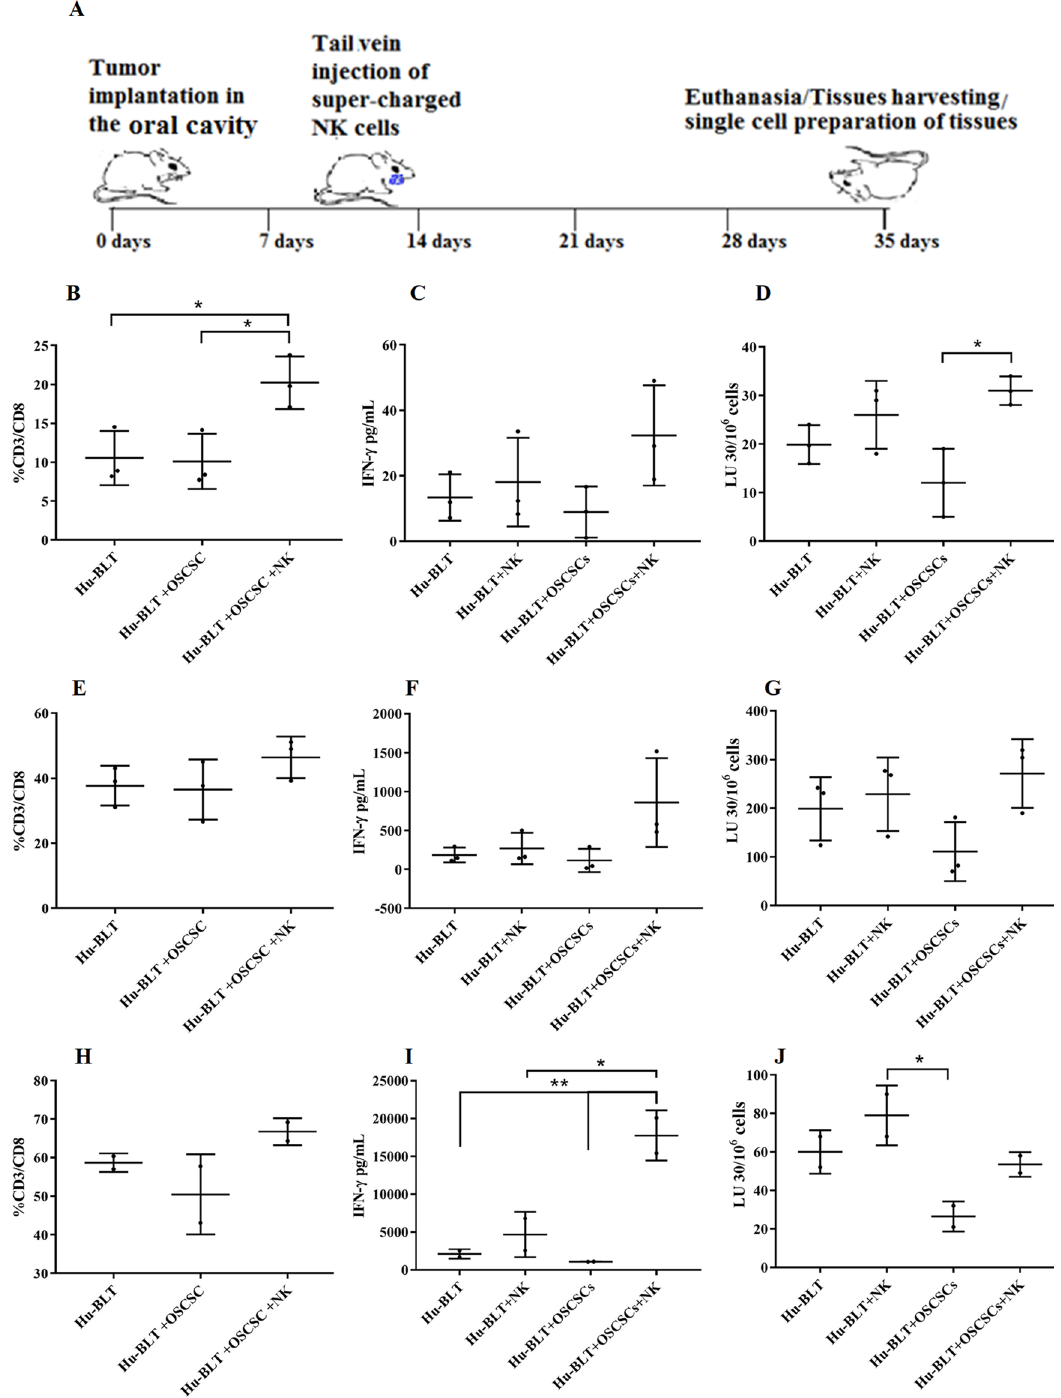
Figure 6. OC-expanded NK cell immunotherapy increased CD8 + T cells, IFN-γ secretion, and NK cell-mediated cytotoxicity in BM, spleen, and peripheral blood of hu-BLT mice. Hu-BLT mice were orthotopically injected with 1 × 10 6 human OSCSCs into the floor of the mouth. One to two weeks after the tumor implantation, mice received OC-expanded NK cells via tail-vein injection. The disease progression and weight loss were monitored for another 3–4 weeks (n = 3) (A) . Hu-BLT mice were implanted with OSCSC tumors and were injected with NK cells as depicted in Fig. 6A. At the end of experiment, hu-BLT mice were sacrificed; the spleens, BM, and peripheral blood were harvested; and single cell suspensions were obtained and cultured as described in the Materials and Methods section. Surface expressions of CD3 and CD8 were analyzed on day 7 of BM cultures (n = 3) (B) , spleen cultures (n = 3) (E) , and PBMC cultures (n = 2) (H) using flow cytometry. The supernatants were harvested from the cultures on day 7 of BM culture (n = 3) (C) , spleen culture (n = 3) (F) , and PBMC culture (n = 2) (I), and the secretions of IFN-γ were determined using single ELISA. Cytotoxicity of day 7 cultured BMs (n = 3) (D) , spleens (n = 3) (G) , and PBMCs (n = 2) (J) were determined against OSCSCs using standard 4-h 51 Cr release assay. LU 30/10 6 cells were determined using the method described in Fig.